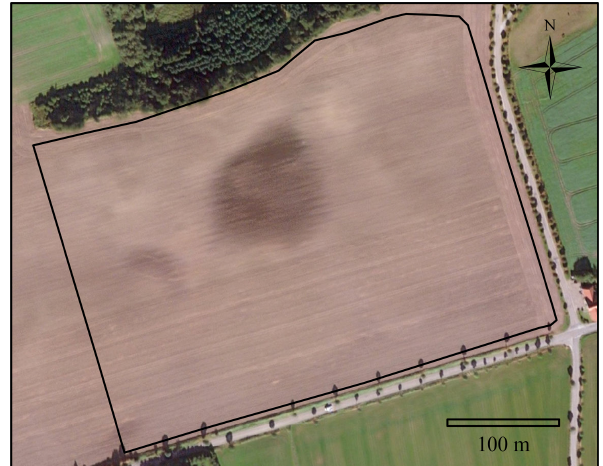
Figure 14. Orthophoto of the study area from 27 September 2016 (Esri, 2019). Sources: Esri, DigitalGlobe, Earthstar Geographics, CNES/Airbus DS, GeoEye, USDA FSA, USGS, Aerogrid, IGN, IGP, and the GIS User